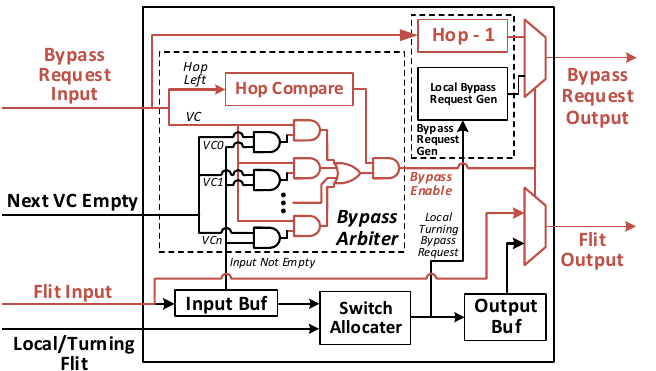
Figure 6. Micro-architecture of the proposed NoC.